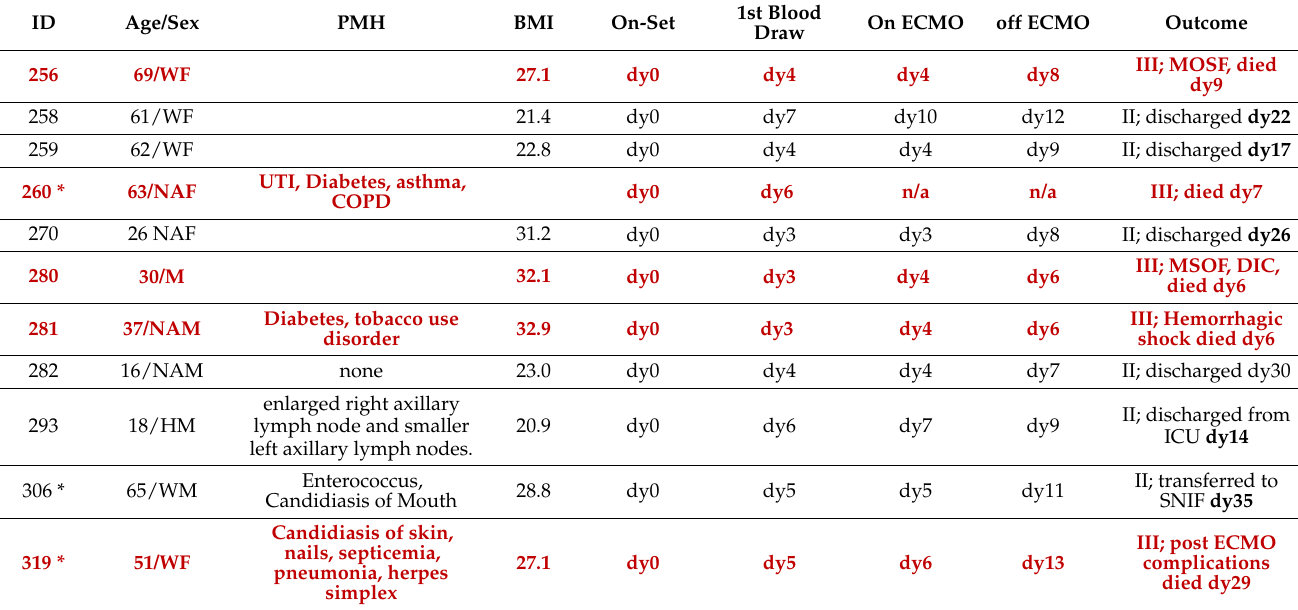
Table 1. Summary of available data on patient history (red and bold font indicates Class III